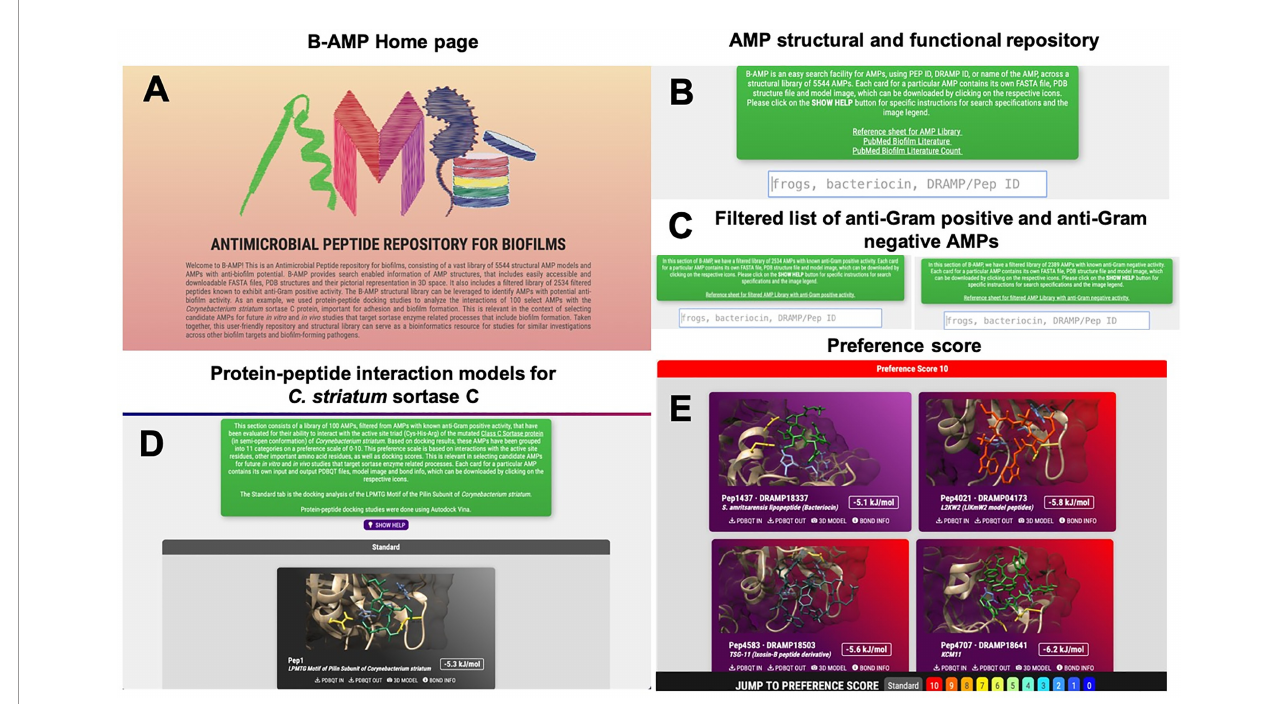
FIGURE 1 | Features and usage of B-AMP (A) B-AMP is a manually curated structural and functional repository of AMPs for bio fi lm studies (B) This user-friendly, search enabled repository includes predicted structures for 5544 AMPs, searchable by their Pep ID, DRAMP ID, name and source, and a comprehensive list of AMP annotations to existing bio fi lm literature sources (C) B-AMP also includes a separate subset of AMPs fi ltered by known anti-Gram positive and anti-Gram negative activity. For each peptide, the repository includes FASTA fi les, PDB fi les, and predicted and chosen 3D models (D, E) B-AMP hosts protein – peptide interaction models of AMPs docked to bio fi lm targets, using the sortase-pilin machinery of C . striatum as a case study. For the 100 AMPs selected for in silico molecular docking, the repository hosts protein-peptide docking models, input & output PDBQT fi les, images, and AMPs categorized in order of preference, based on docking scores and interacting residues. B-AMP will be continually updated with new structural AMP models, AMP interaction models with potential bio fi lm targets and annotations to relevant bio fi lm literature. Artwork in (A) was done by Shreeya